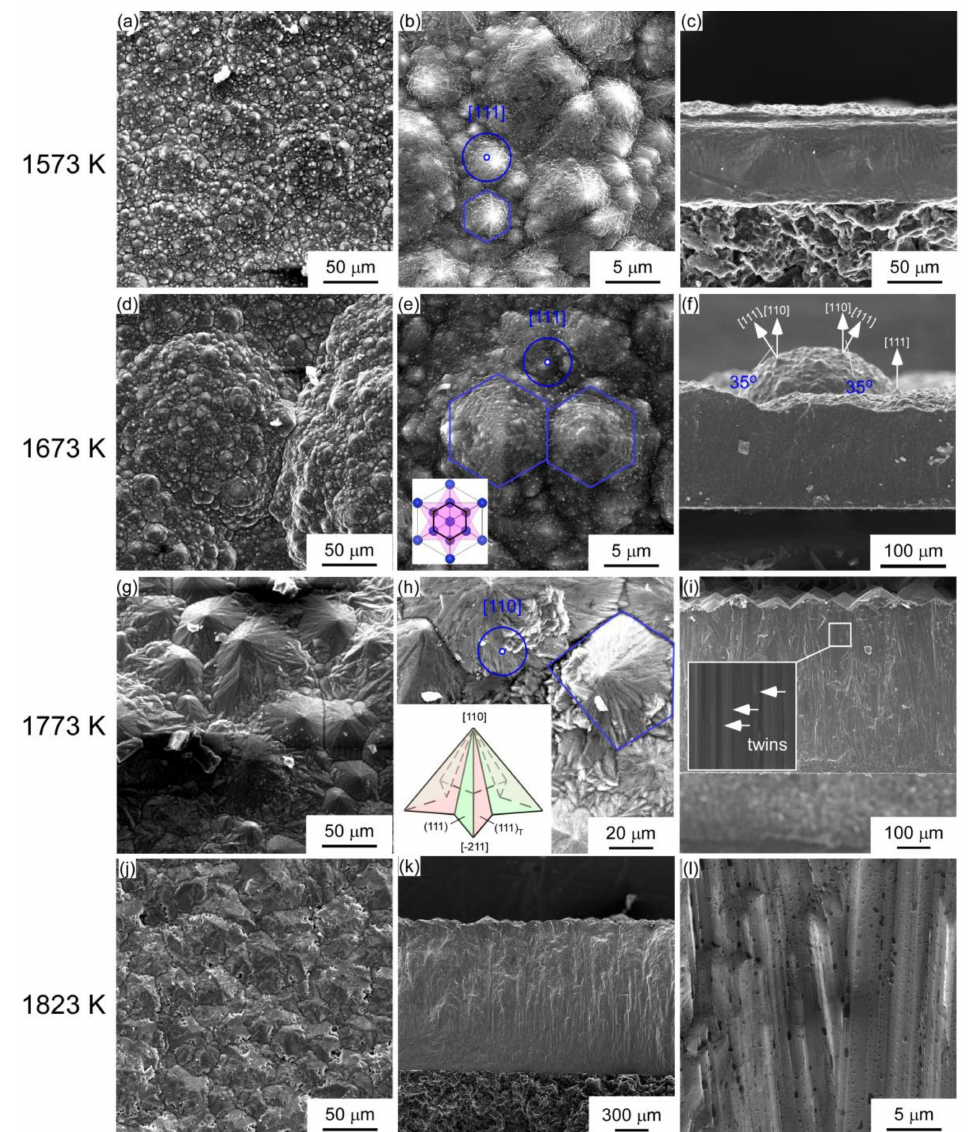
Figure 2. Surface and cross-section morphology of 3C-SiC deposits prepared at P tot = 4 kPa, T dep = ( a )–( c ) 1573 K, ( d )–( f ) 1673 K, ( g )–( i ) 1773 K, and ( j ),( k ) 1823